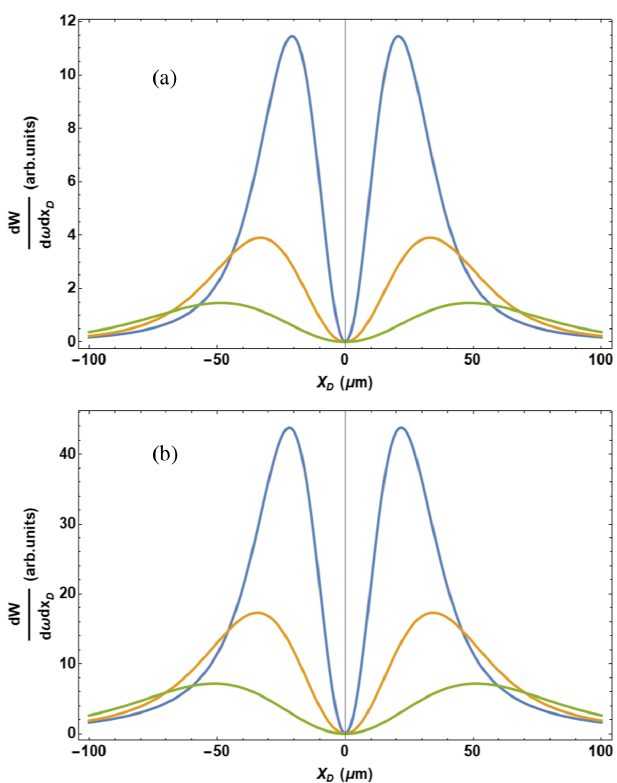
FIG. 11. Calculated COTR based beam profiles for a beam size of Σ x ¼ 16 μ m (blue), 26 μ m (yellow) and 40 μ m (green curve). The profiles are calculated for λ ¼ 0 . 5 μ m based on approxima- tion Eq. (11) and for two different beam energies γ ¼ 1000 (a) and γ ¼ 2000 (b).